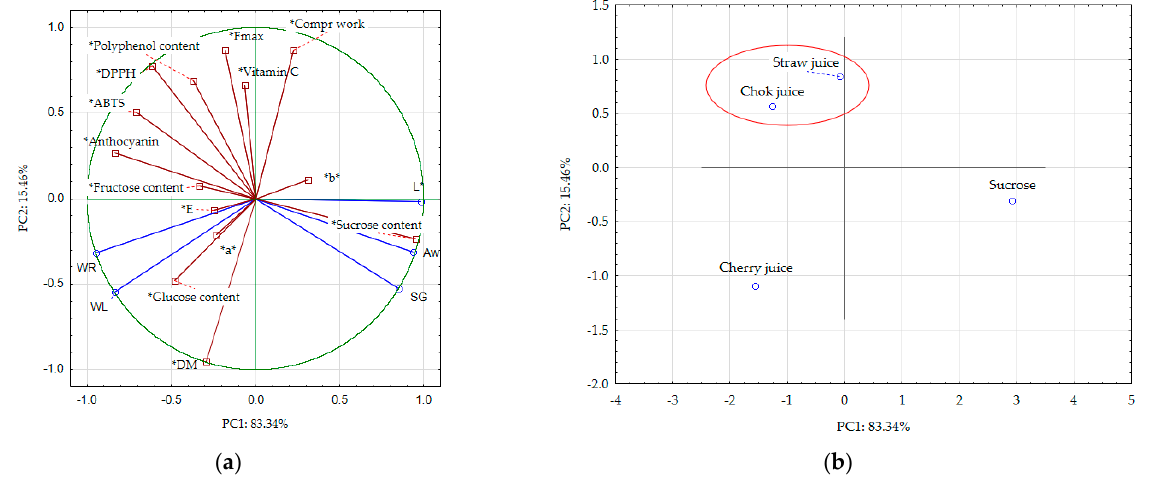
Figure 11. PCA analysis: ( a ) PCA loading plot of two principal components, ( b ) score plot presenting analyzed samples in term of PC1 vs. PC2. Markings: DM—dry matter content, WL—water loss, SG—solid gain, Aw—water activity; L*, a*, b*, Δ E—color parameters. Red lines indicate active data included in the PCA analysis, blue lines - additional data. The red line on ( b ) concerns the separation of a group of data with a similar effect of osmotic agent on the examined physicochemical indicators.